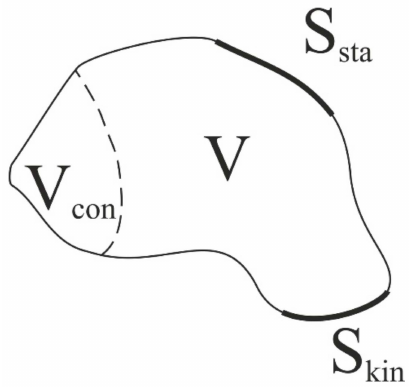
Figure 1. Scheme for problem